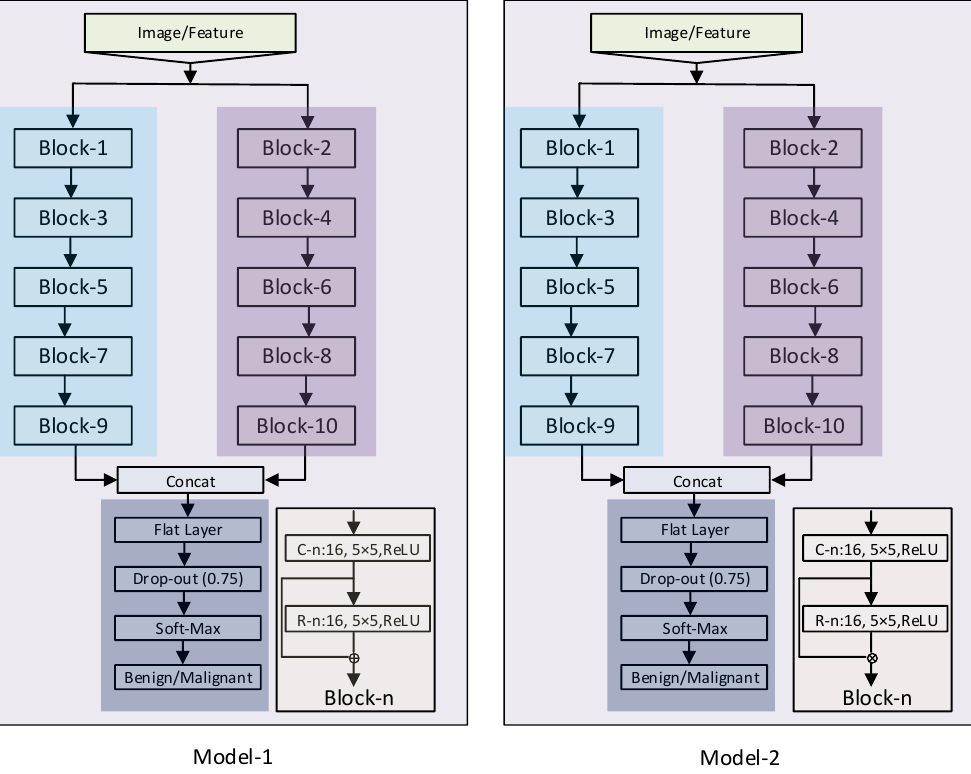
Figure 8. Architecture of Model-1 on the left and the architecture of Model-2 on the right.